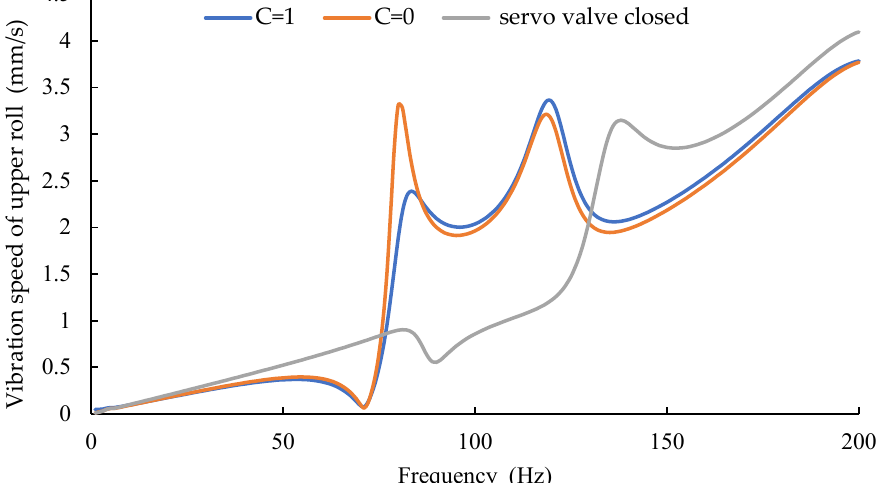
Figure 9. Amplitude frequency diagram of vibration speed of upper work roll.